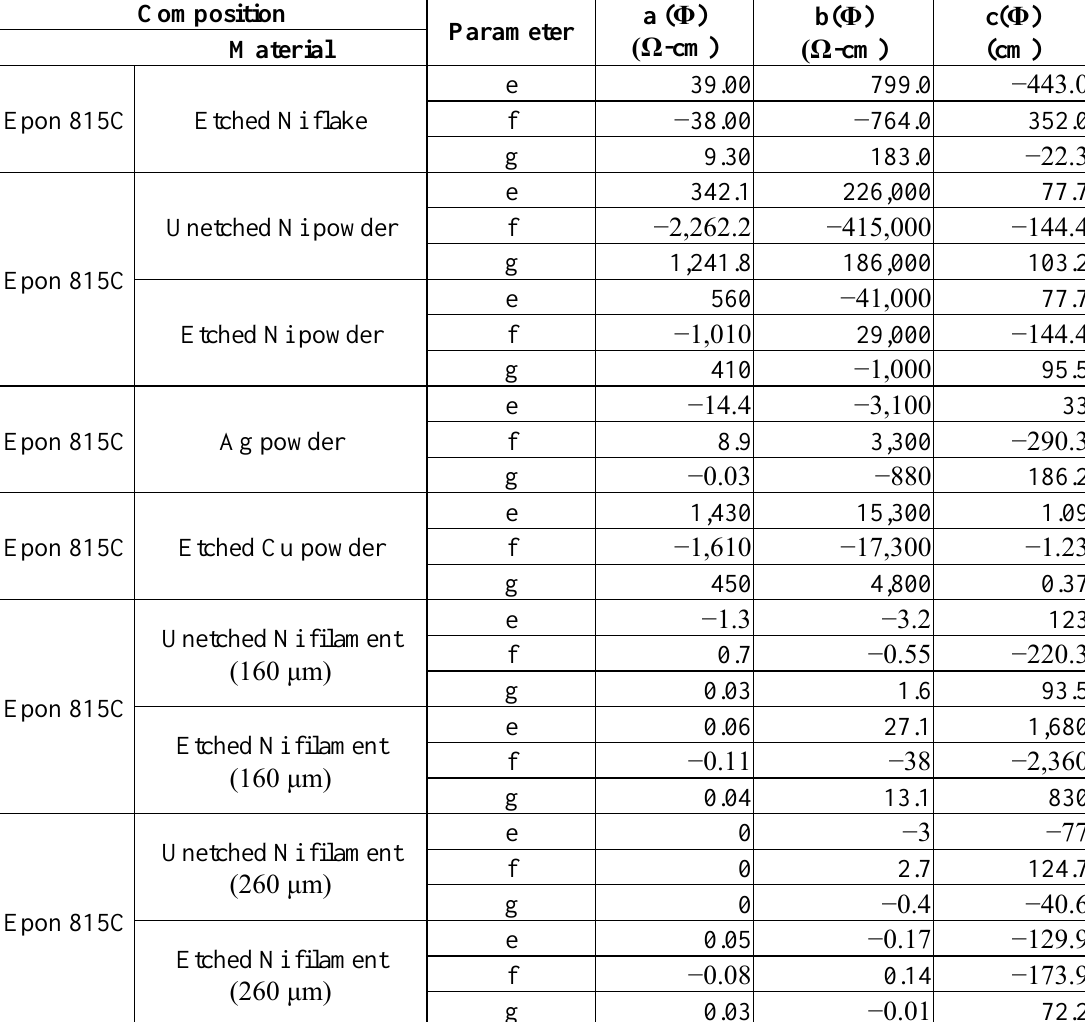
Table 5. The parameters e, f and g of Equation 18 for a(Φ ), b(Φ ) and c(Φ) with various filled Epon 815C adhesive systems.